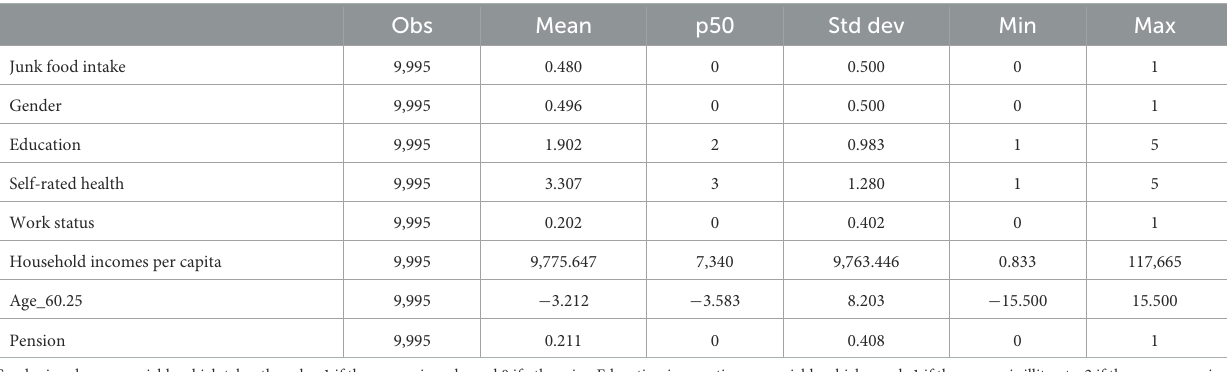
TABLE 1 Summary statistics.